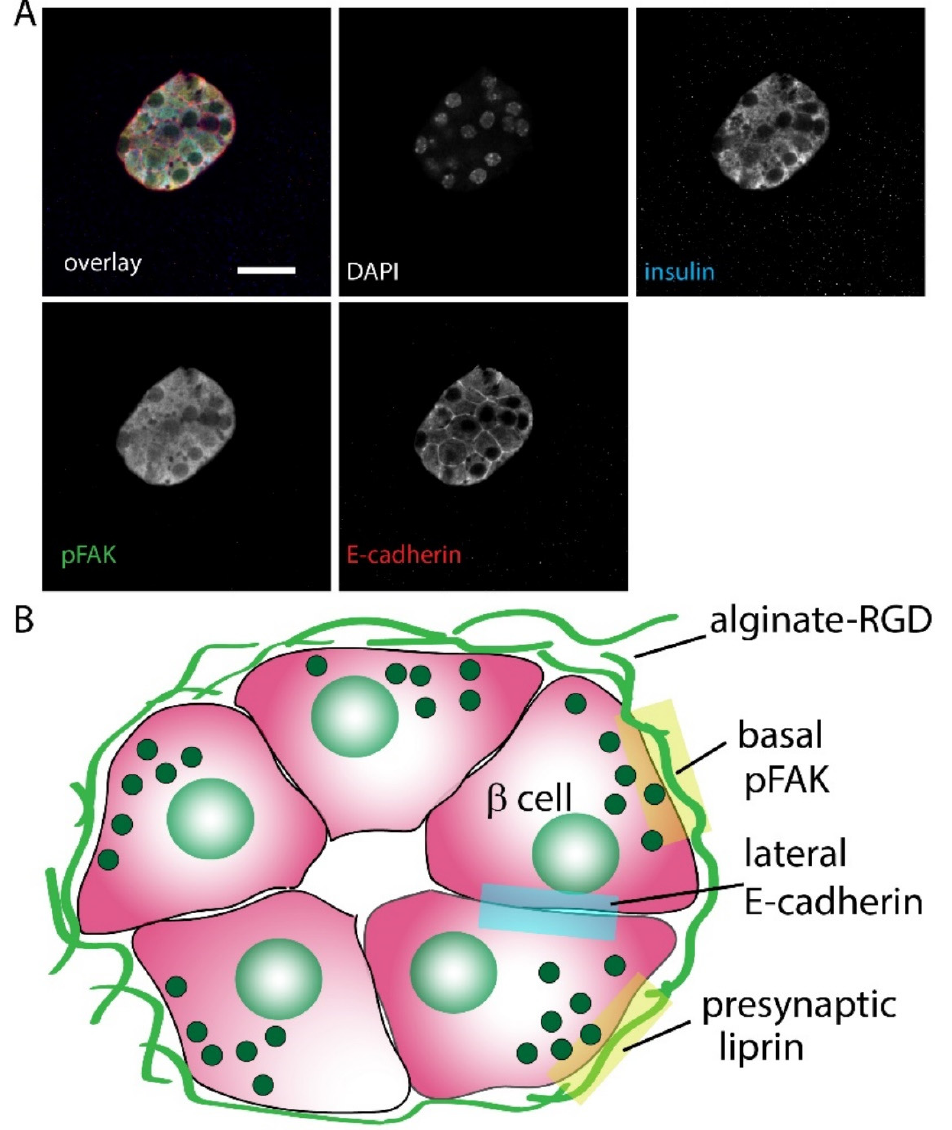
Figure 5. Immunostaining showed formation of E-cadherin junctions between the β cells. ( A ) Example images from clusters within alginate-RGD showed that E-cadherin was enriched where individual β cells contacted each other and was excluded from the outer domain where the cells contacted the gel. ( B ) Cartoon representation of the β cell spheroids showing the organisation of cell structure and orientation to the RGD alginate.